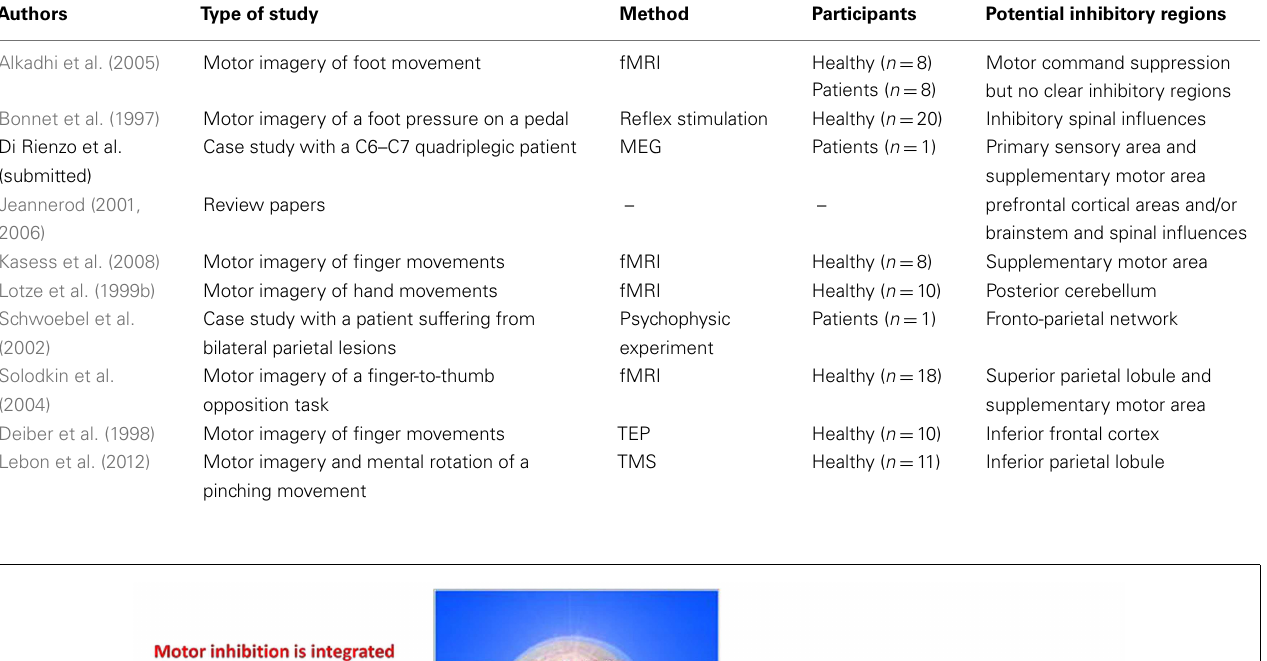
Table 3 | Studies addressing the question of the motor inhibition during motor imagery.